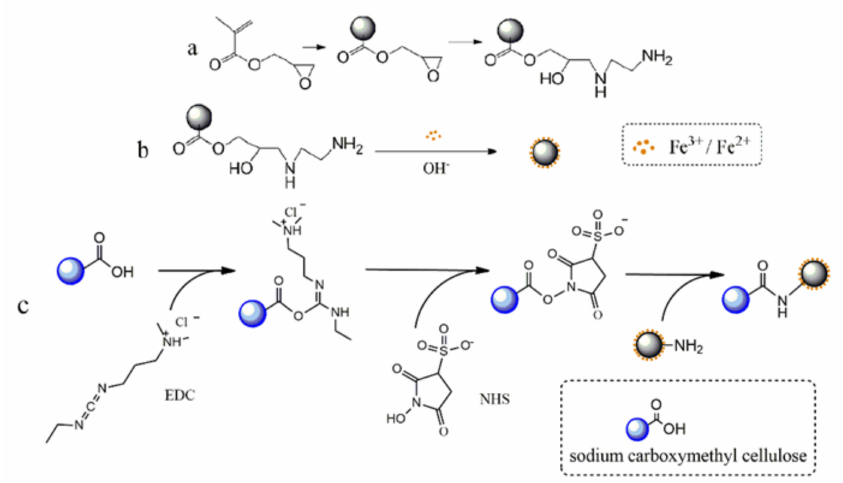
Figure 1. Schematic diagram of the preparation of magnetic anion-exchanged microspheres. ( a ) Preparation and amino modification of PGMA Polymer Microspheres. ( b ) Synthesis of amino magnetic microspheres. ( c ) Carboxyl coating on the surface of amino magnetic